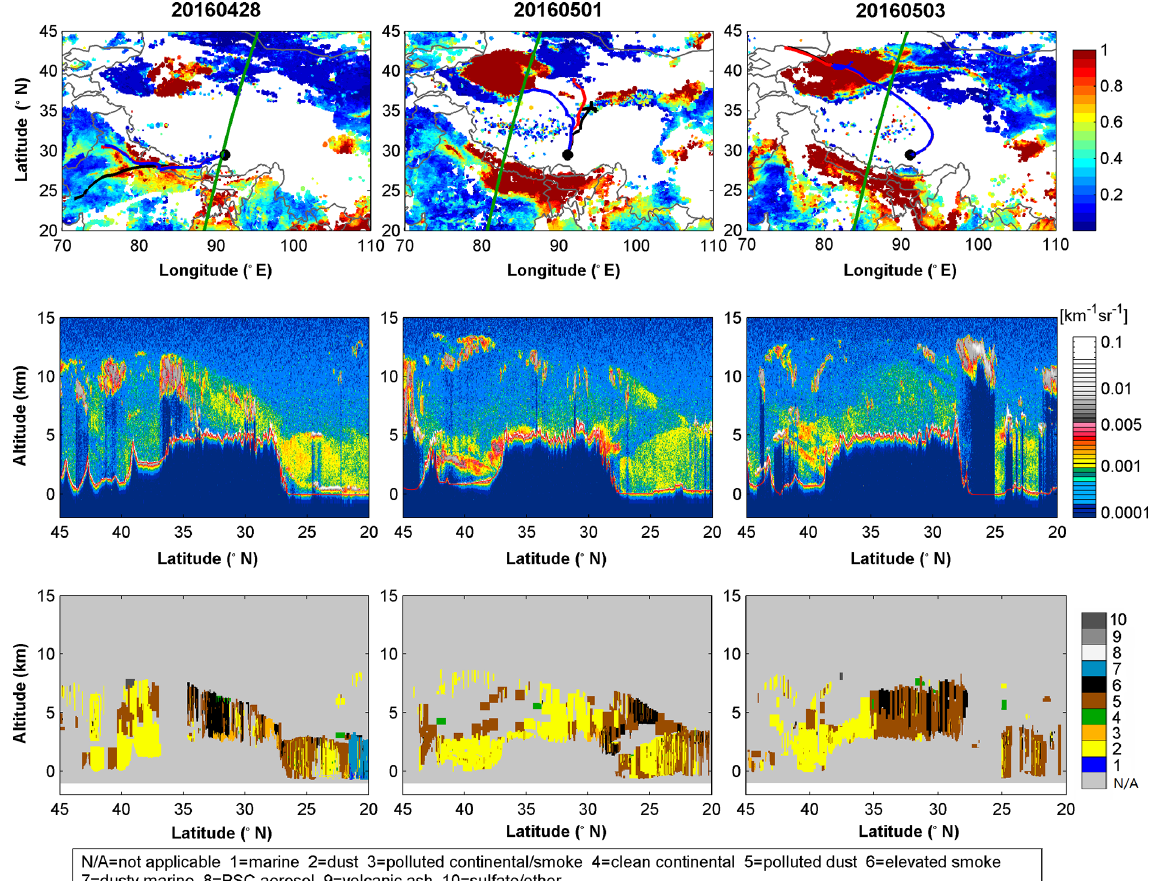
Figure 15. The MODIS_AOD at 550nm and 72h back trajectories ending at Lhasa at three heights above the ground level (10m in black, 500m in red and 1000m in blue lines) (the first row); the CALIOP-derived vertical profile of total attenuated backscatter at 532nm (the second row); and the vertical feature mask of aerosol on 28 April, 1 May and 3 May 2016 (the third row). The green lines in the panels of the first row stand for the CALIOP ground